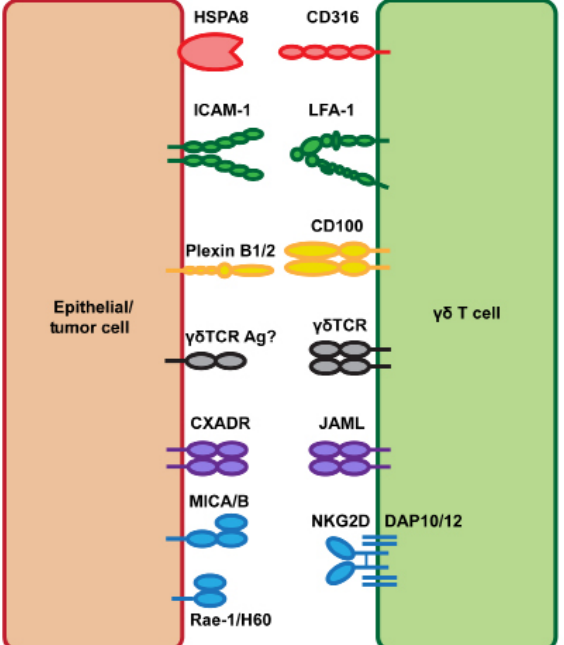
Figure 1. Tissue-resident γδ T cell costimulatory ligand interactions. Tissue-resident γδ T cells express the costimulatory molecules NKG2D, JAML, CD100, LFA-1, and CD316. Upon tissue damage or malignant transformation, epithelial cells upregulate expression of both γδTCR antigens and the costimulatory ligands Rae-1/H60 [MHC class I polypeptide-related sequence A and B (MICA/B) in human], CXADR, plexin B1/2, ICAM-1, and HSPA8 allowing for γδ T cell activation and their promotion of tissue homeostasis. HSPA8: heat shock protein family A member 8; ICAM-1: intercellular adhesion molecule-1; Ag: antigens; CXADR: coxsackie and adenovirus receptor; Rae-1: retinoic acid early inducible 1; H60: histocompatibility 60; DAP10/12: DNAX-activating protein 10/12